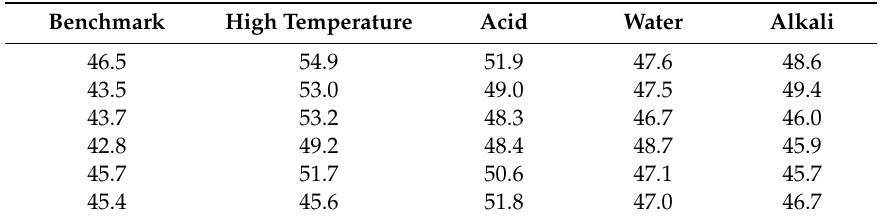
Table 3. Compressive strengths of high-early-strength cement with di ff erent dispersed processes and unprocessed short carbon fibers. (Unit: MPa).